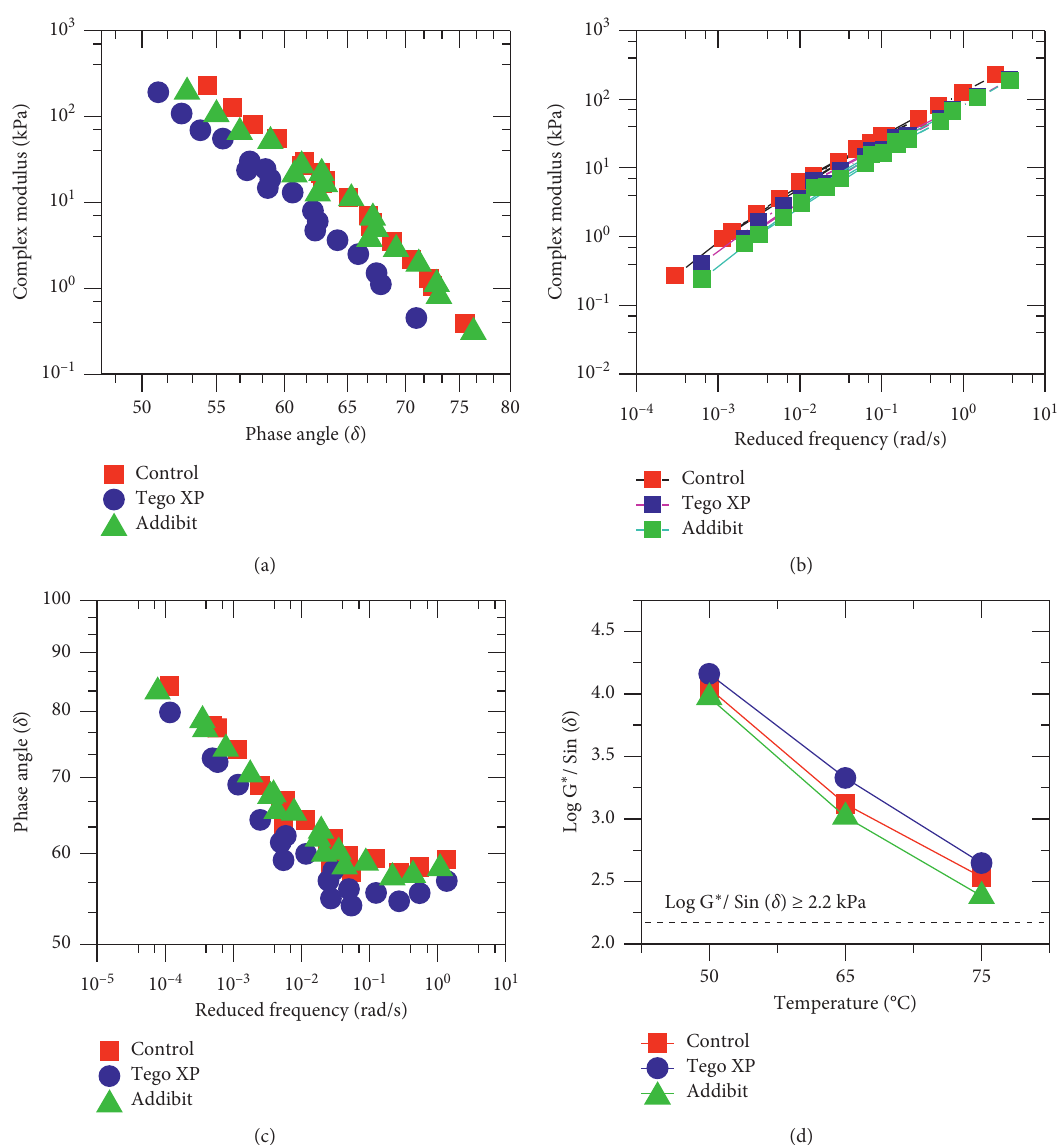
Figure 7: (a) Master curve, (b) phase Angle, (c) black diagram, and (d) Shenoy rutting parameter (0.1Hz frequency) of CRM binders with and without WMA additives at high temperatures 50 ° C, 64 ° C, and 75 °